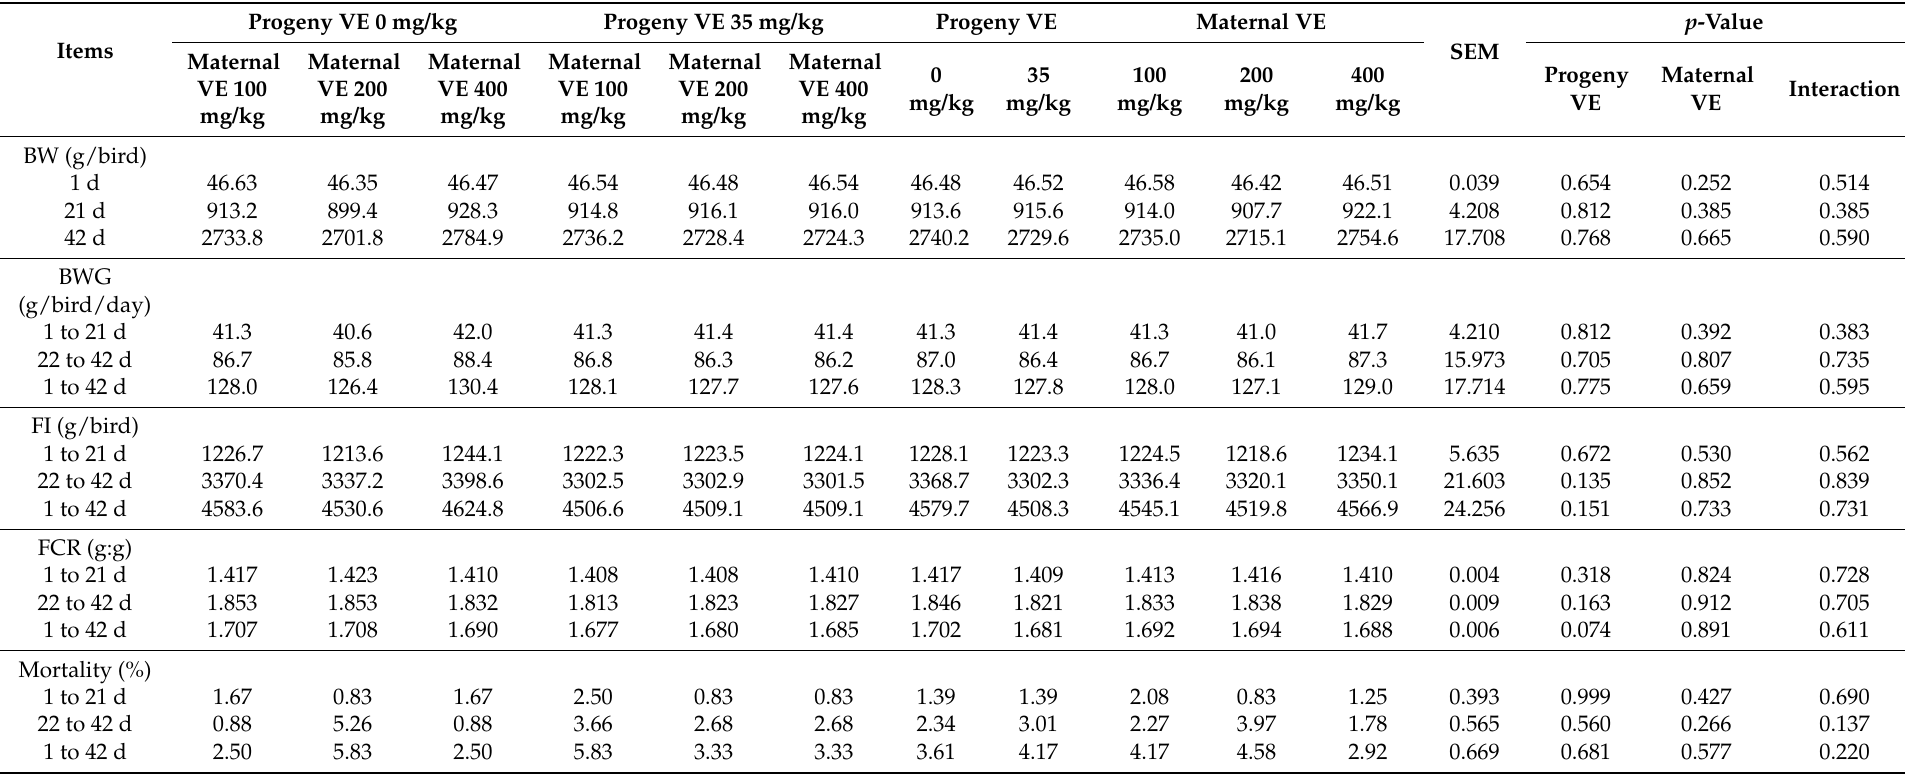
Table 2. Effects of maternal and progeny dietary vitamin E on the growth performance of offspring hatched from unstored eggs (trial 1) 1,2